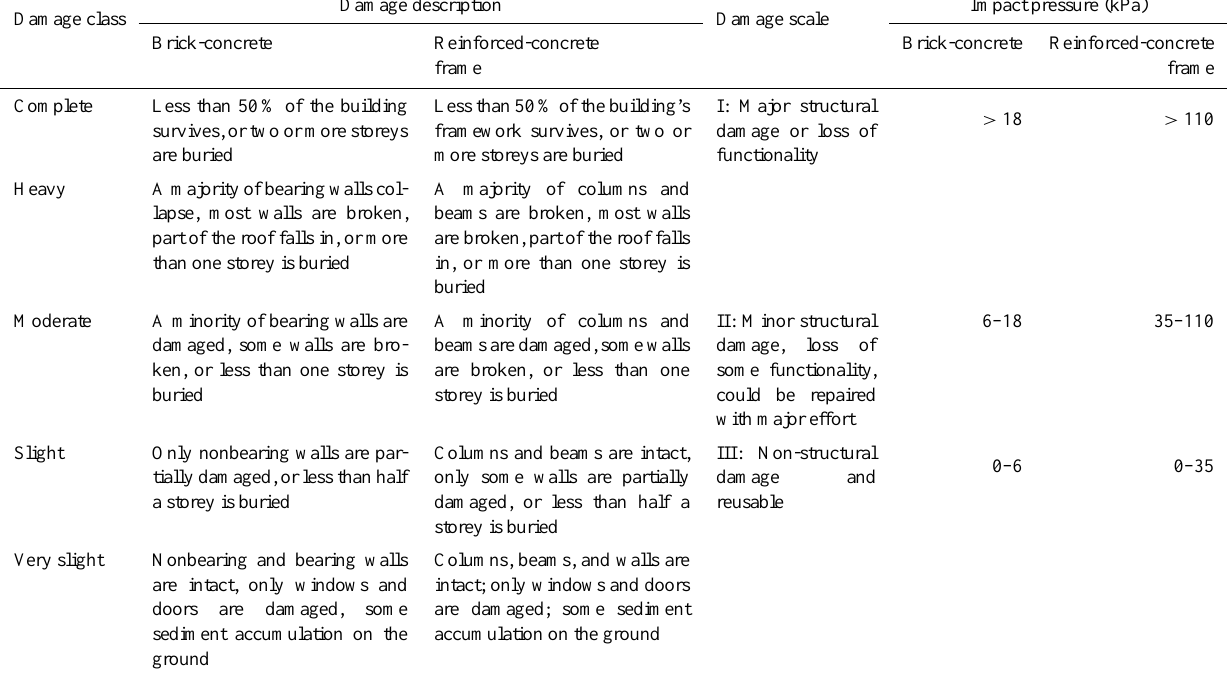
Table 3. Classification of damage to civil architecture by debris